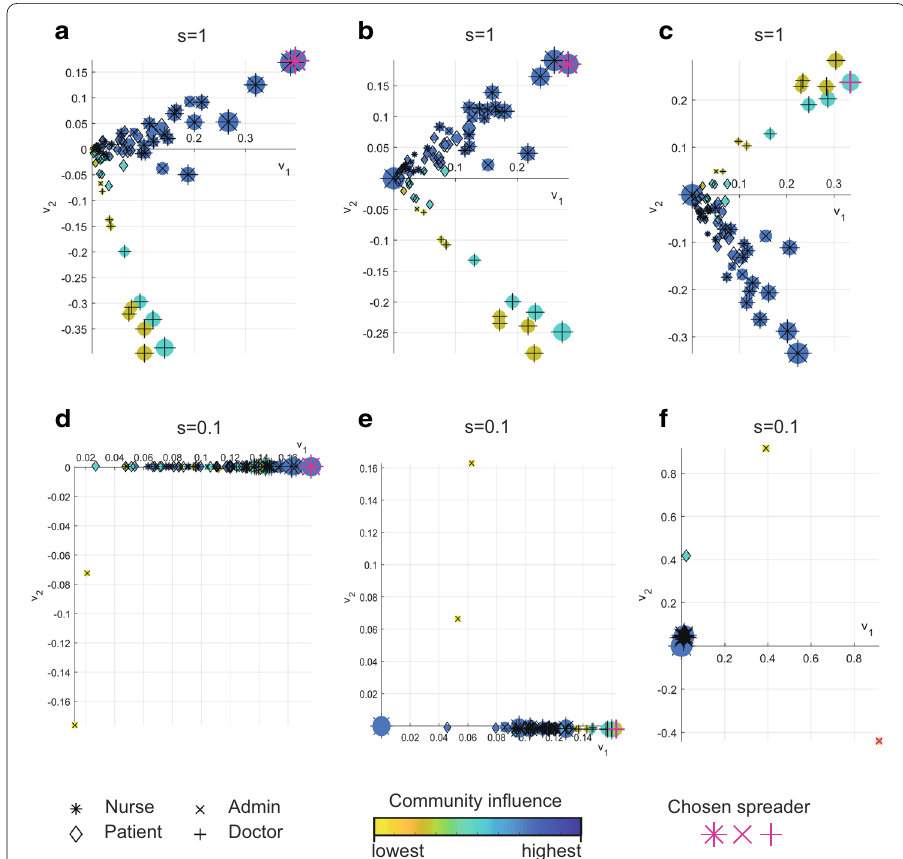
Fig. 1 Spreader selection for hospital ward contact network ( τ = 1 ). CDI determined communities, defined for a are highlighted in b – f to visualise the iterative process of spreader selection when s = 1 ( a – c ) and s = 0.1 ( d – f ). In a , d the original network is embedded in a Euclidean space defined by the dominant eigenvectors ( v 1 and v 2 ) of L e . The node with the largest v 1 value is the chosen spreader. In b , e , L e is updated by removing connections from the chosen spreader. In c , f L e is updated again by removing connections from the chosen spreader in b , e respectively. Markers denote hospital role and dot colour denotes community where community influence is ranked in a according to largest v 1 entry in each community. Node size is mostly proportional to weighted degree, with a minimum size limit used to aid